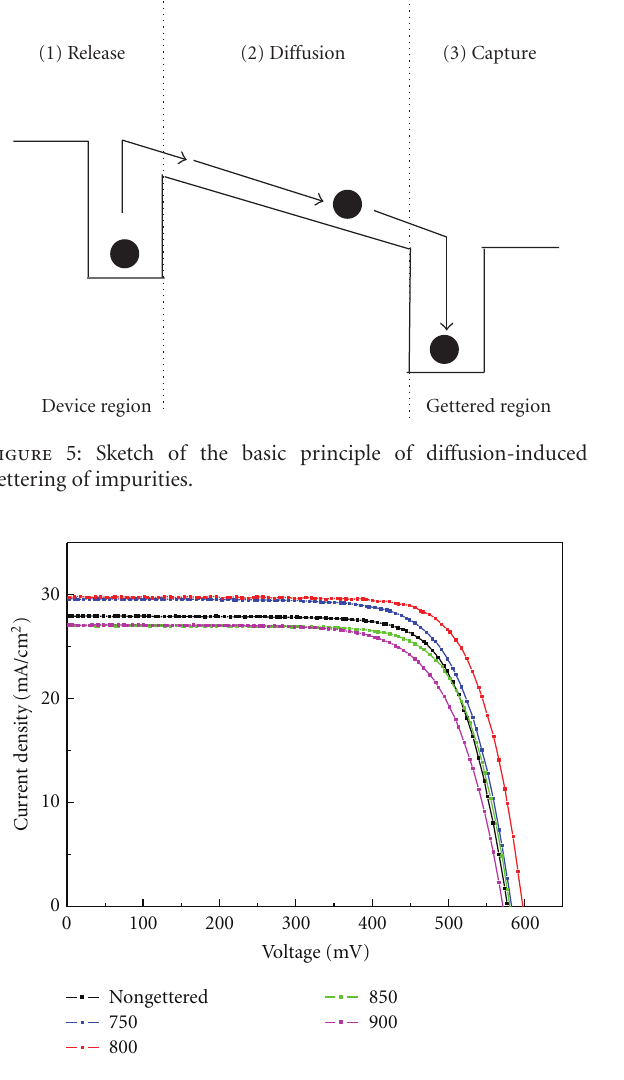
Figure 6: Illuminated current density-voltage curves of nonget- tered and gettered samples.